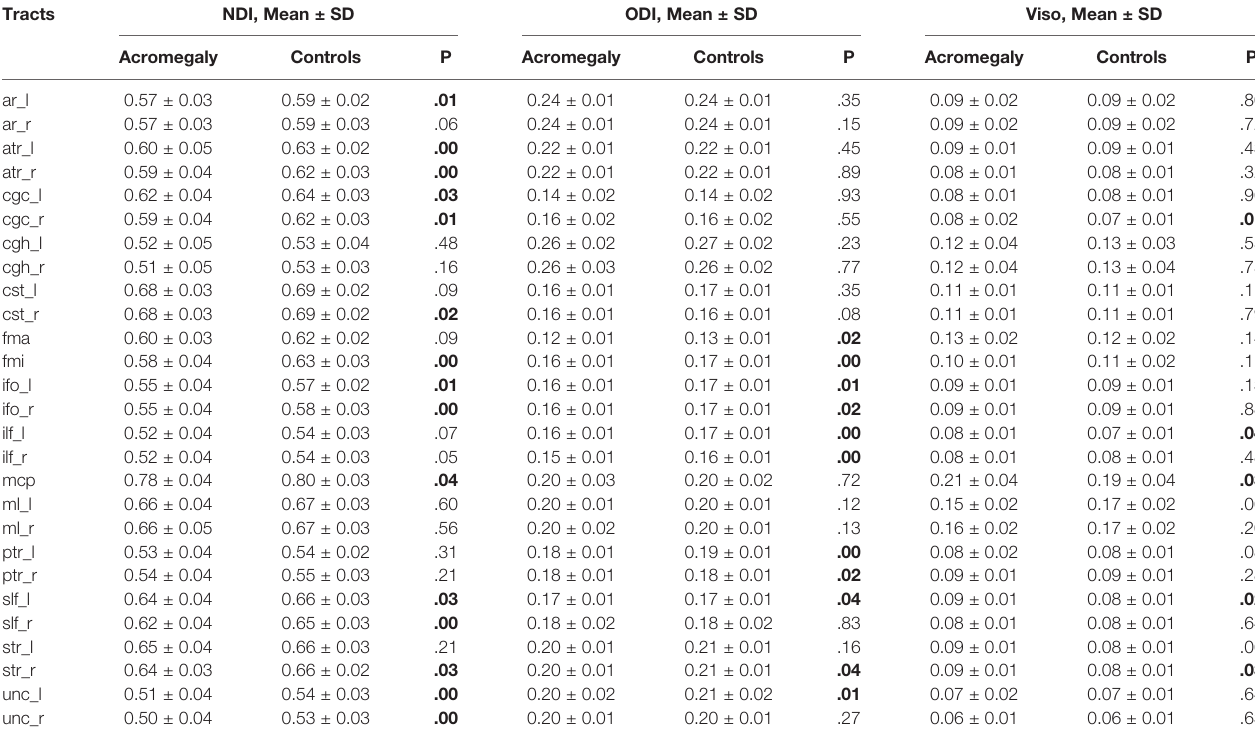
TABLE 3 | NODDI metrics including NDI, ODI, and Viso in white matter for ROI analysis between acromegaly and